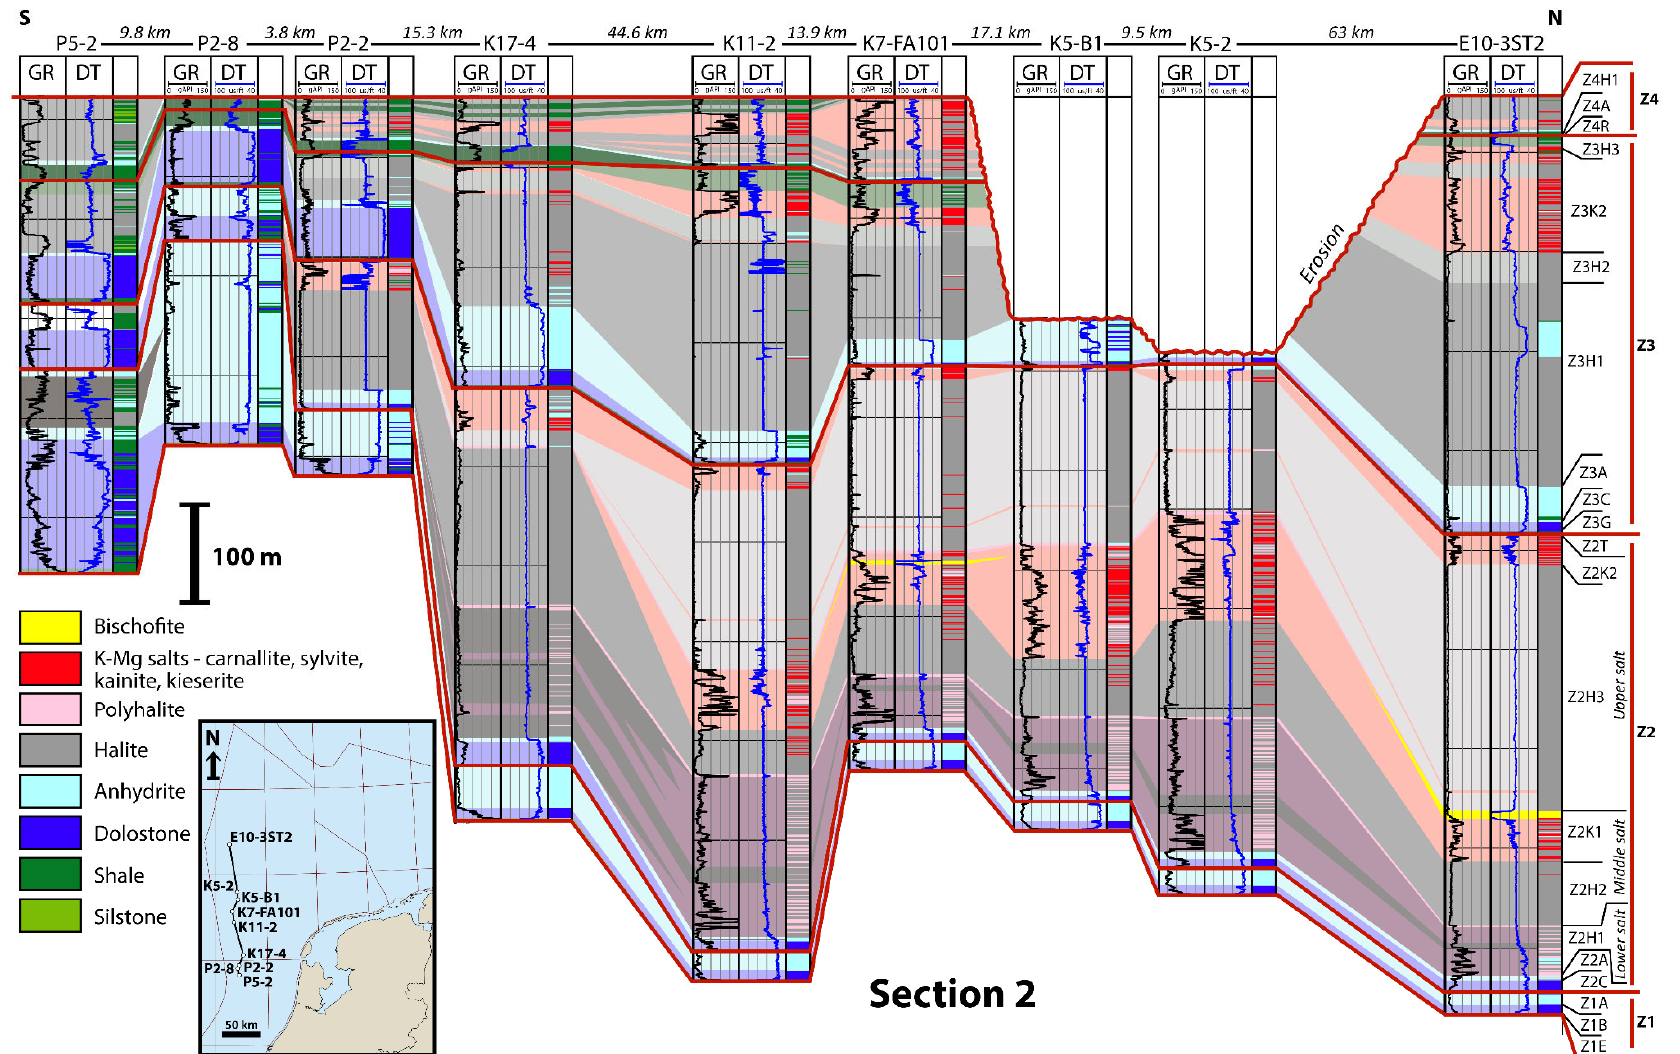
Figure 4. Correlative cross ‐ section 2.